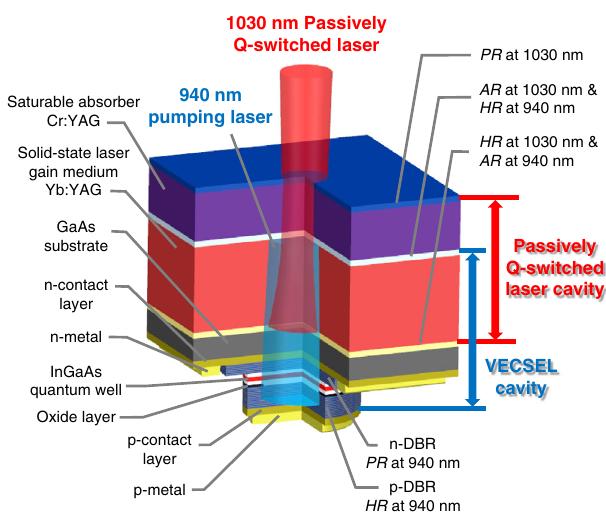
Fig. 1 | Schematic ofchip-scale semiconductor/solid-statevertically integrated laser. The VECSEL cavity and the passively Q-switched laser cavity are optically coupled at the solid-state gain medium of